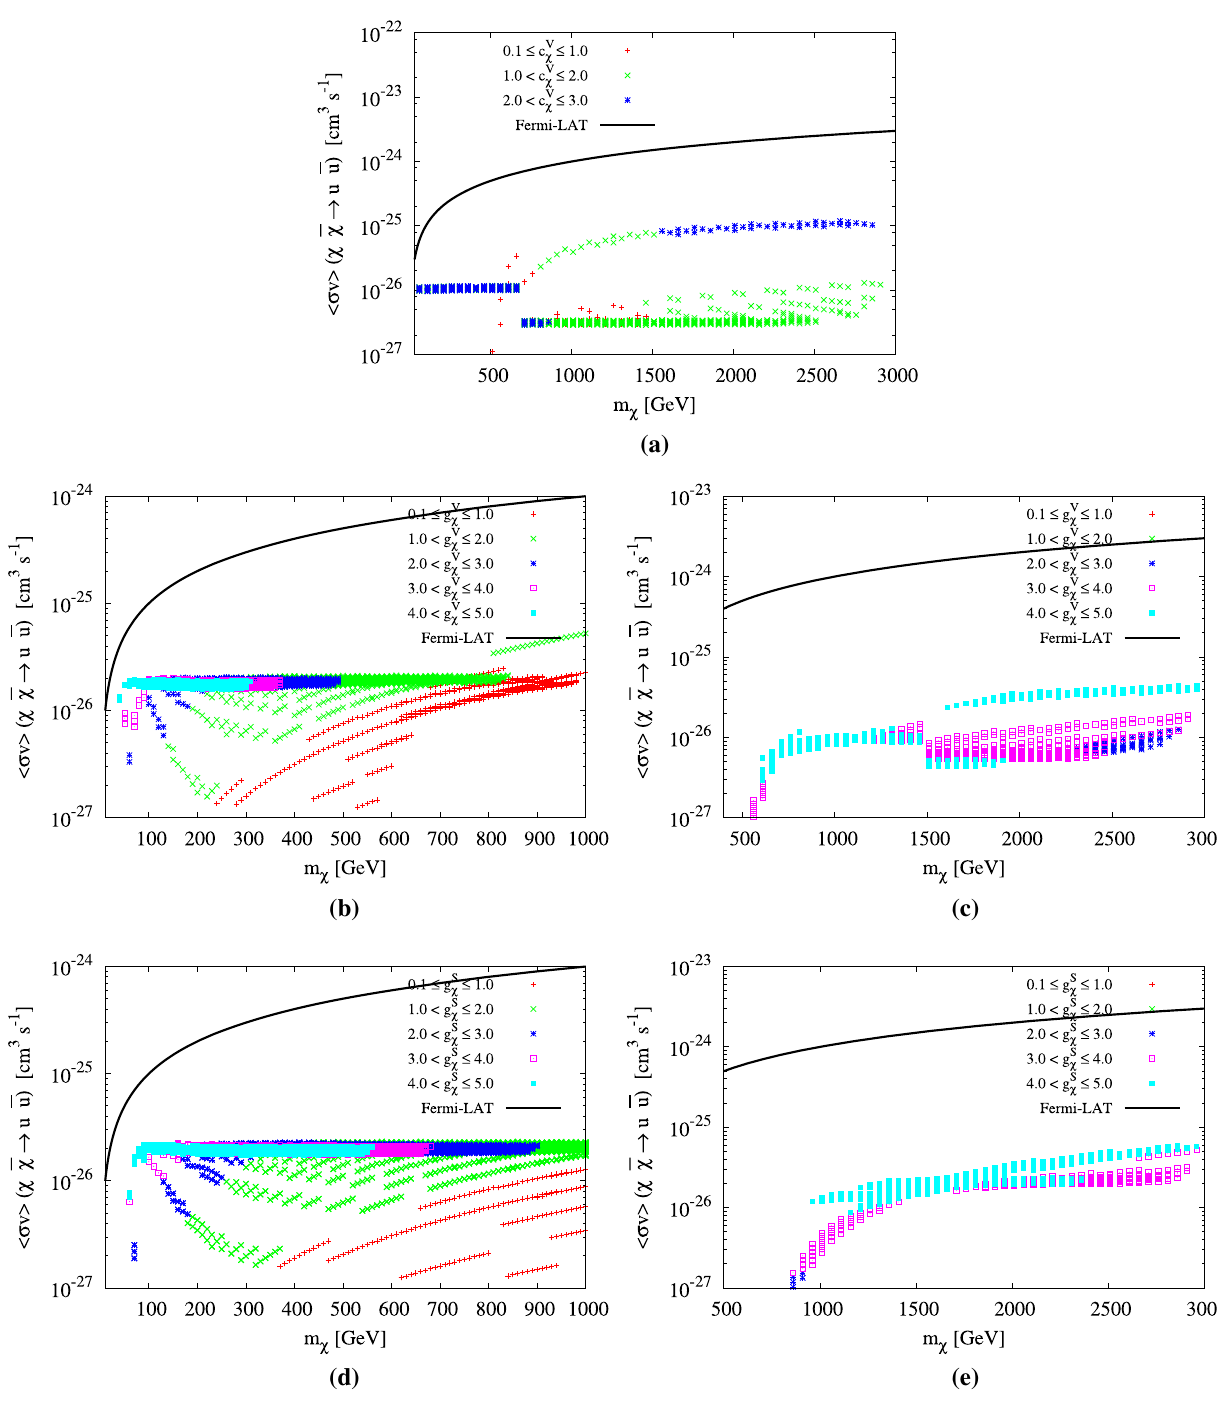
Fig. 3 The prediction for the DM χ ¯ χ annihilation rate into u ¯ u , as a function of the DM mass m χ . All the parameters are chosen to be con- sistent with the observed relic density. The top panel is for dimension-4 vector interaction. The middle and the bottom panels are for dimension-